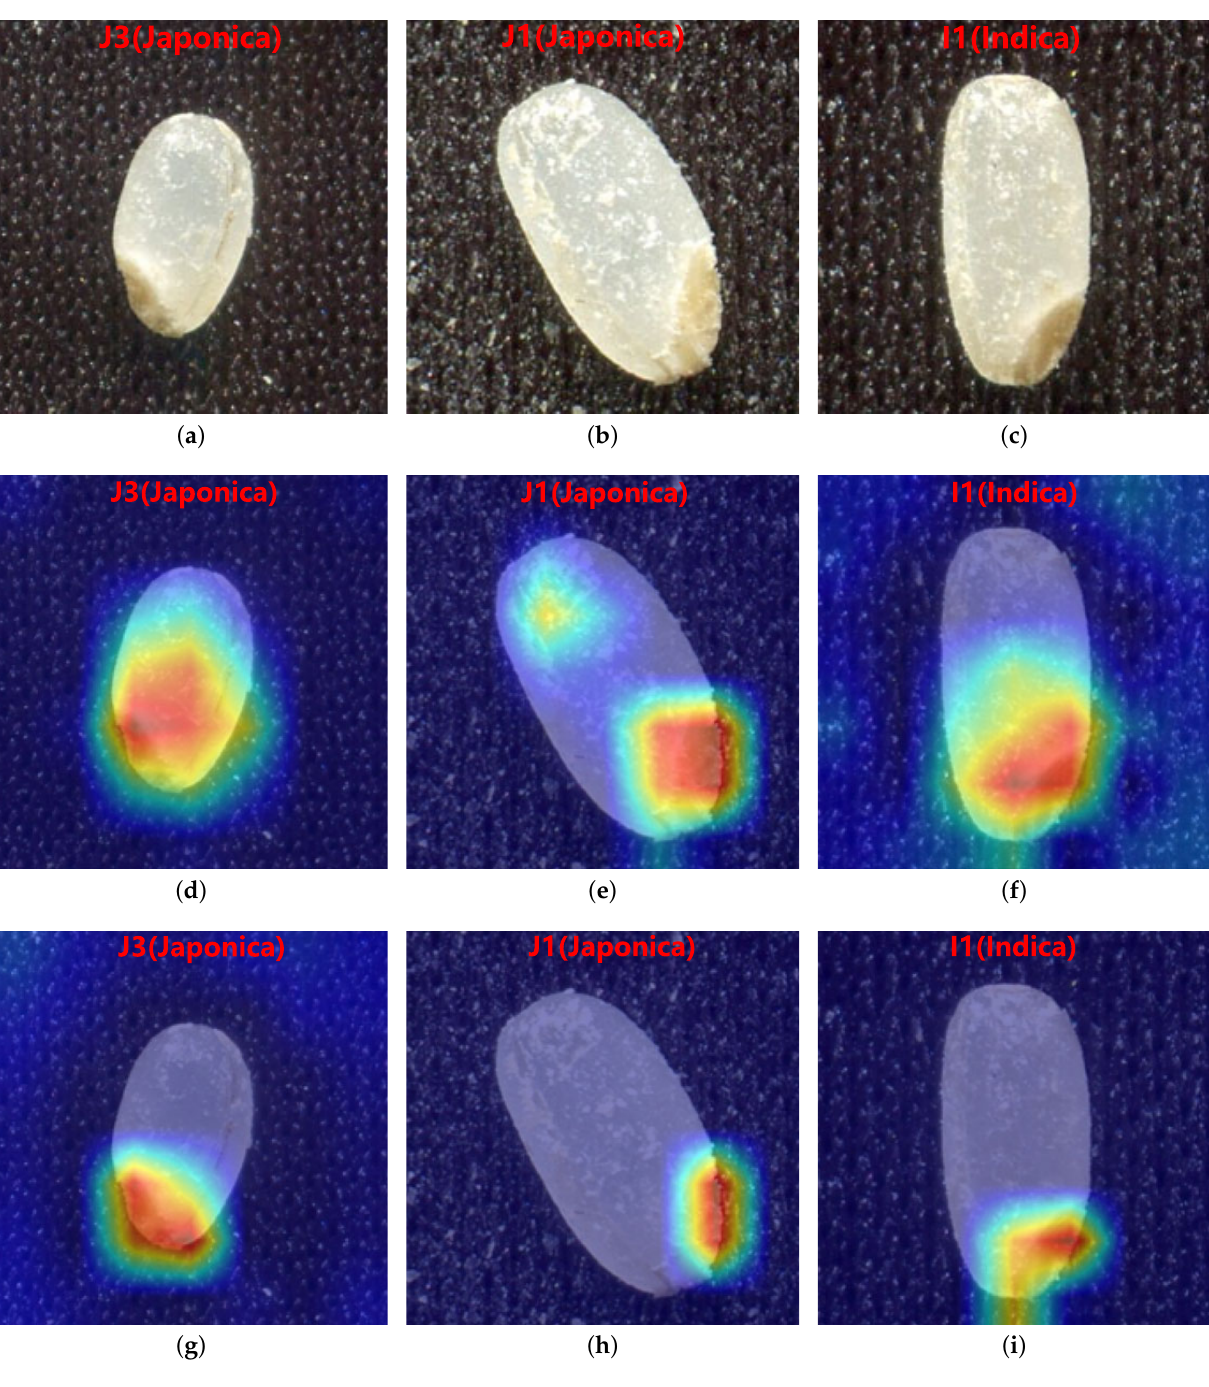
Figure 13. The visualization comparison of three types of rice (J1, J3, I1) between original image ( a – c ), and attention heat map from EfficientNet–B3 ( d – f ), and EfficientNet–B3–DAN ( g – i